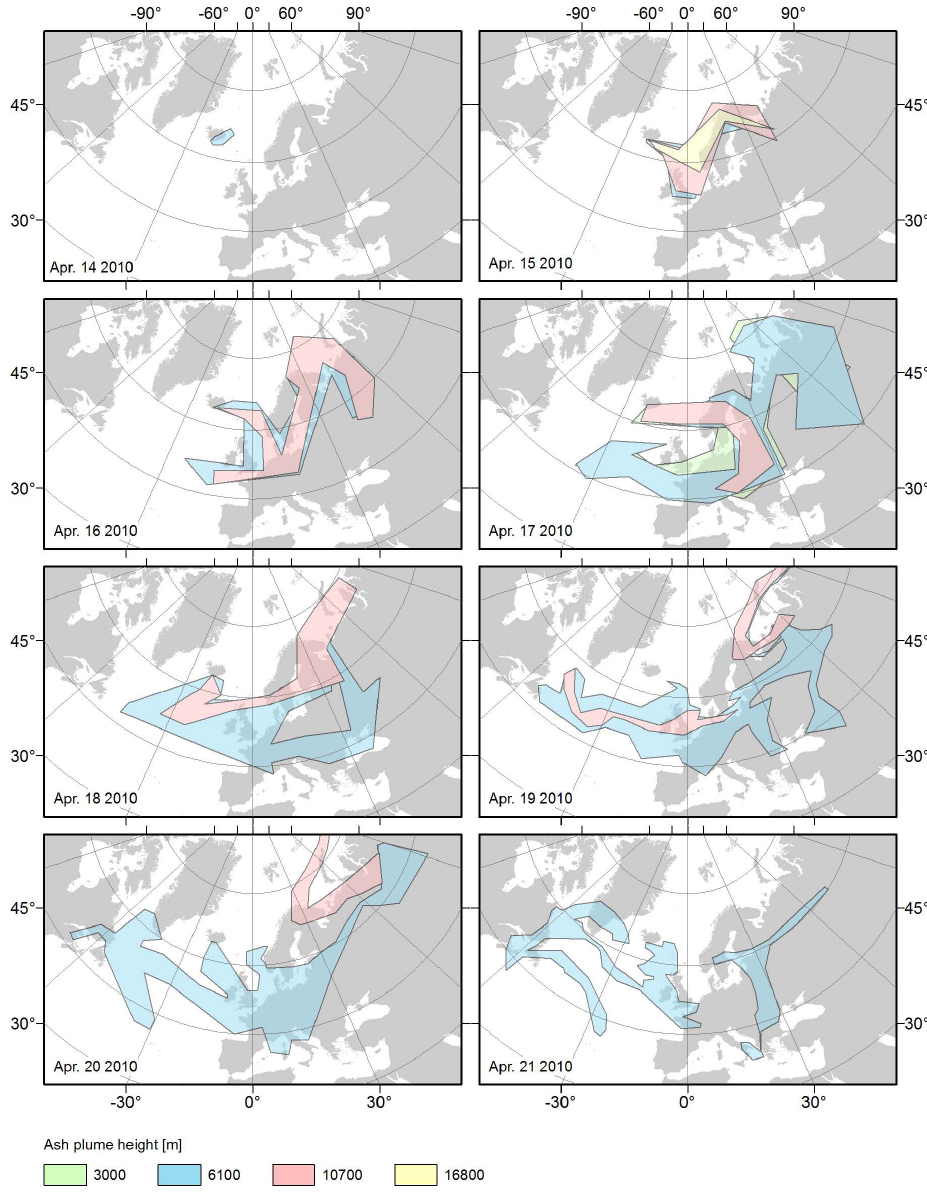
Fig. 5. Volcanic ash dispersion on standard flight levels (3000m – FL100, 6100m – FL200, 10700 m – FL350, 16800m – FL550) for the eruption of Eyjafjallaj¨okull in April 2010. These ash dispersion data are a product of the VAAC